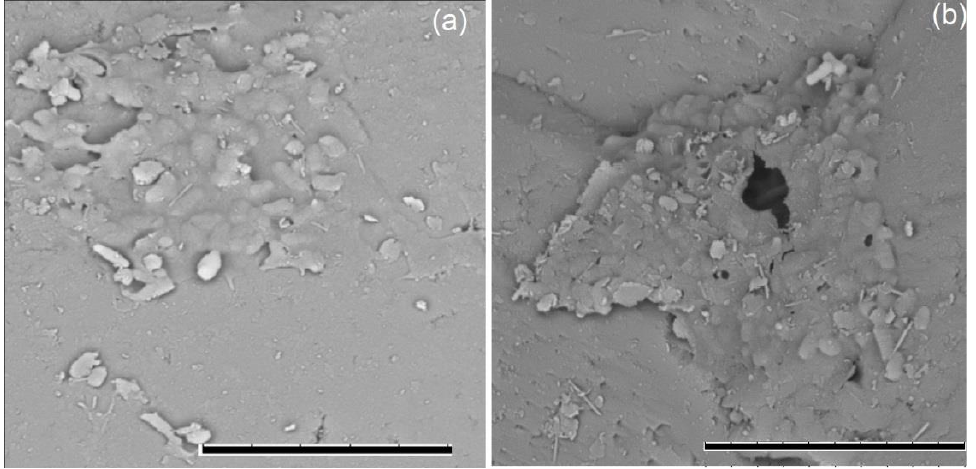
Figure 6. Formation of biofilms on sand with 0.3% ( w/w ) crude oil by strains of Aeromonas salmonicida M3-1 ( a ) and Pseudomonas brenneri M6-6 ( b ) after 30 days of incubation at 9 °C; metal-sprayed dry cells under a TM3000 scanning electron microscope (Hitachi, Tokyo, Japan) at 15 kV accelerating voltage. Bar, 10 µm.